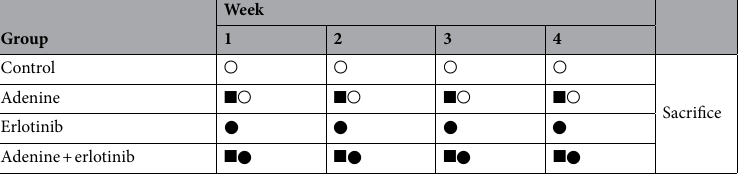
Table 2. Schematic presentation of experimental design. n = 10/group. ○ Mice received 0.9% w/v saline (6 ml/ kg/day, orally by oral gavage). ■ Mice received 0.2% w/w adenine (orally/day with